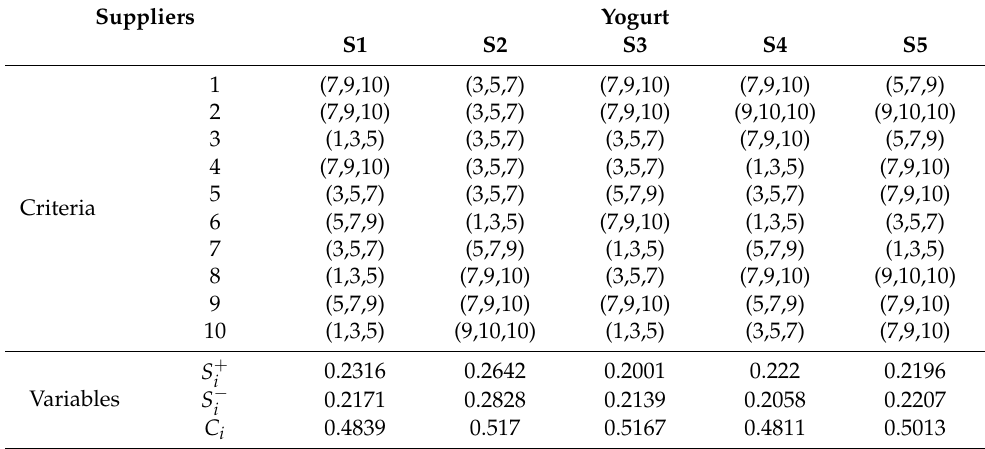
Table A37. Decision matrix considering suppliers and similarity index for